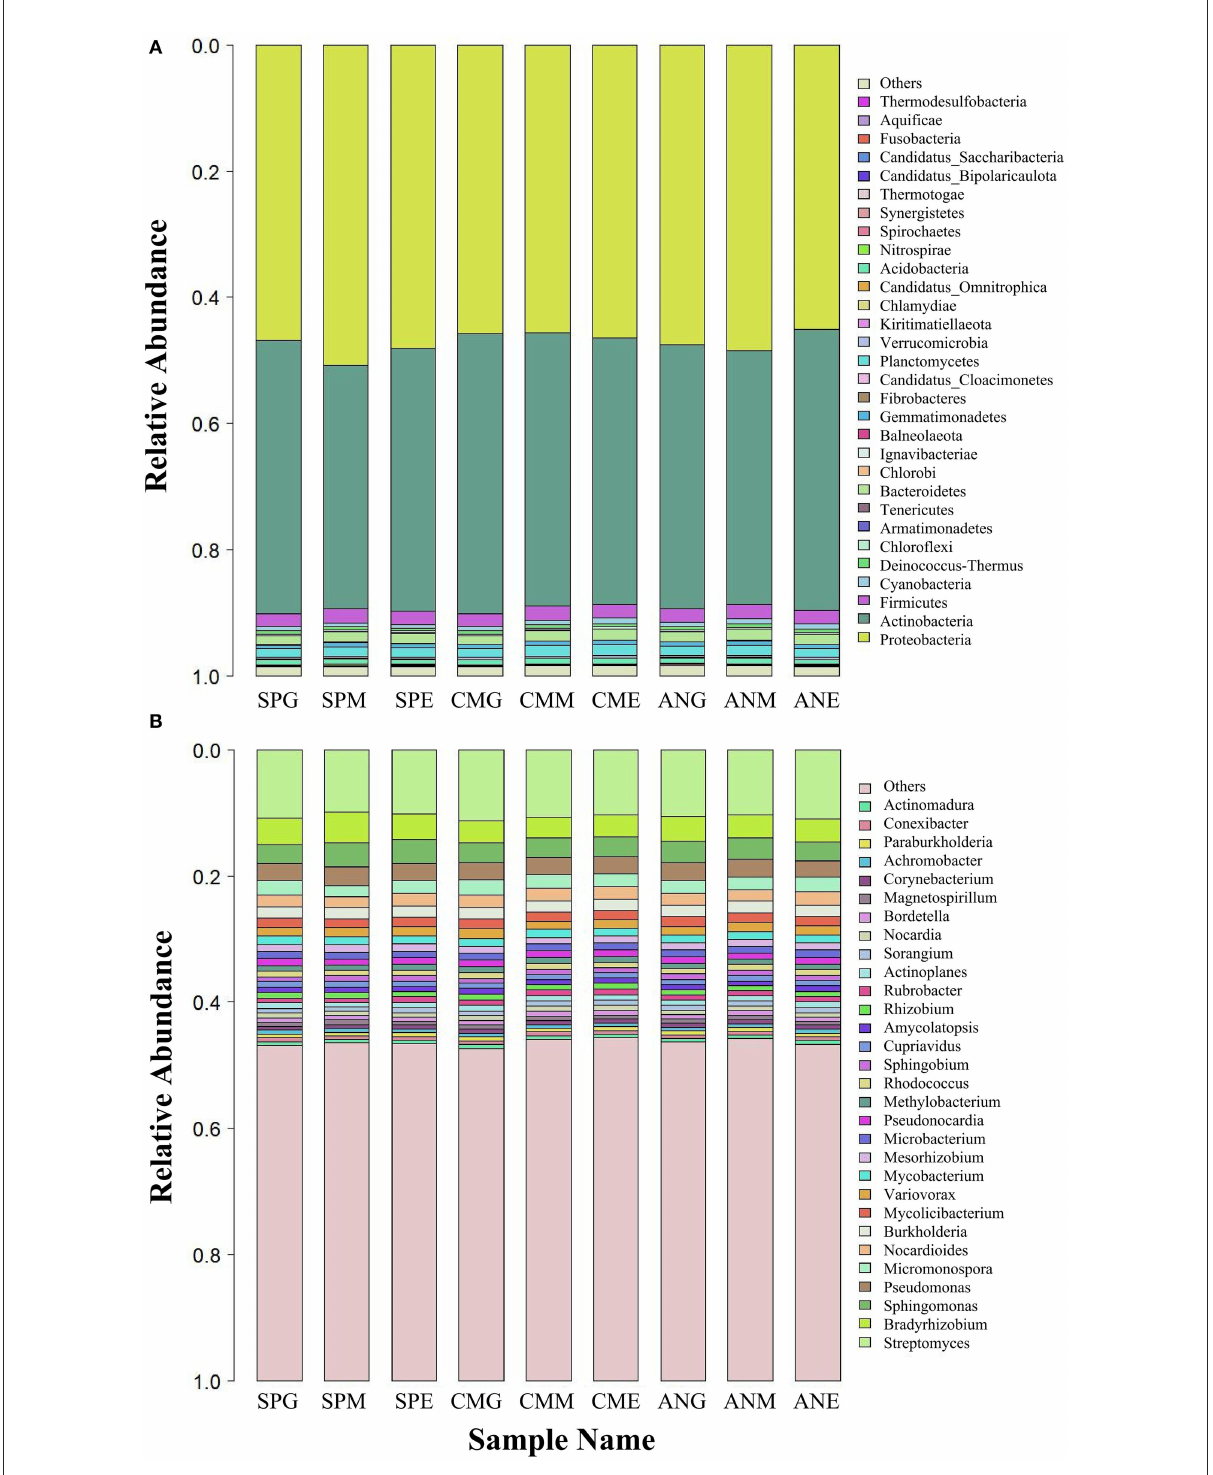
FIGURE2 Relative abundance of the top 30 rhizosphere soil microorganisms at phylum (A) and genus (B) levels under different grassland utilization patterns. SPG, Stipa purpurea group under grazing treatment; SPM, Stipa purpurea group under mowing treatment; SPE, Stipa purpurea group under enclosing treatment; CMG, Carex moorcroftii group under grazing treatment; CMM, Carex moorcroftii group under mowing treatment; CME, Carex moorcroftii group under enclosing treatment; ANG, Artemisia nanschanica group under grazing treatment; ANM, Artemisia nanschanica group under mowing treatment; ANE, Artemisia nanschanica group under enclosing